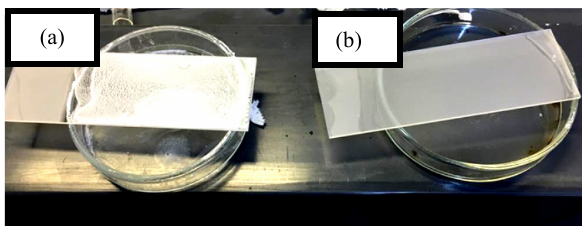
Fig. 1. Glass slides with a natural polyethylene showing the crystallisation of polymer (a) from the solution that formed two separated layers and the slide on (b) is from a homogeneous solution, no.